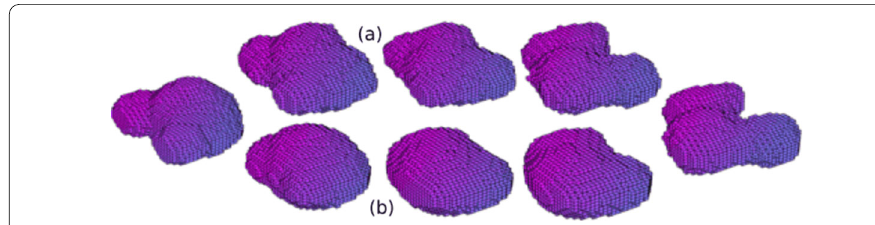
Figure 13 Interpolation between two shapes. ( a ) Morphological distance. ( b ) Spherical harmonics distance